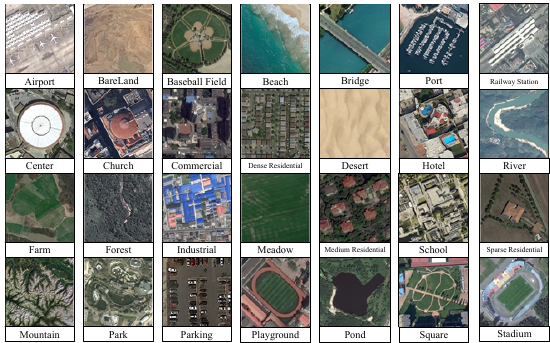
Figure 7. Examples of 28 categories of Scene Images in AID